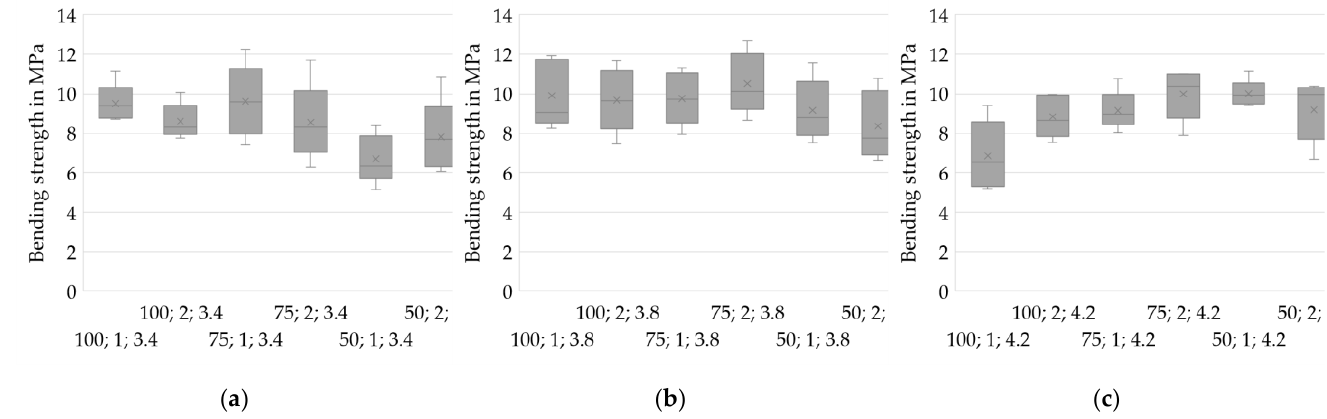
Figure 9. Four-point bending strengths for various drying intensities. Contrary indications: while ( a ) indicates higher strengths at higher layer heights, ( c ) displays tendencies to higher strengths at low layer heights. ( a ) PAV = 3.4 V, n = 5; ( b ) PAV = 3.8 V, n = 5; ( c ) PAV = 4.2 V, n = 5.